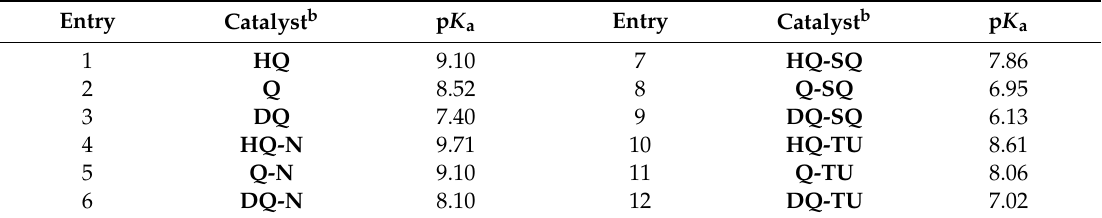
Table 1. The p K a values of the conjugate acids of basic quinuclidine tertiary amine part in cinchona catalysts a